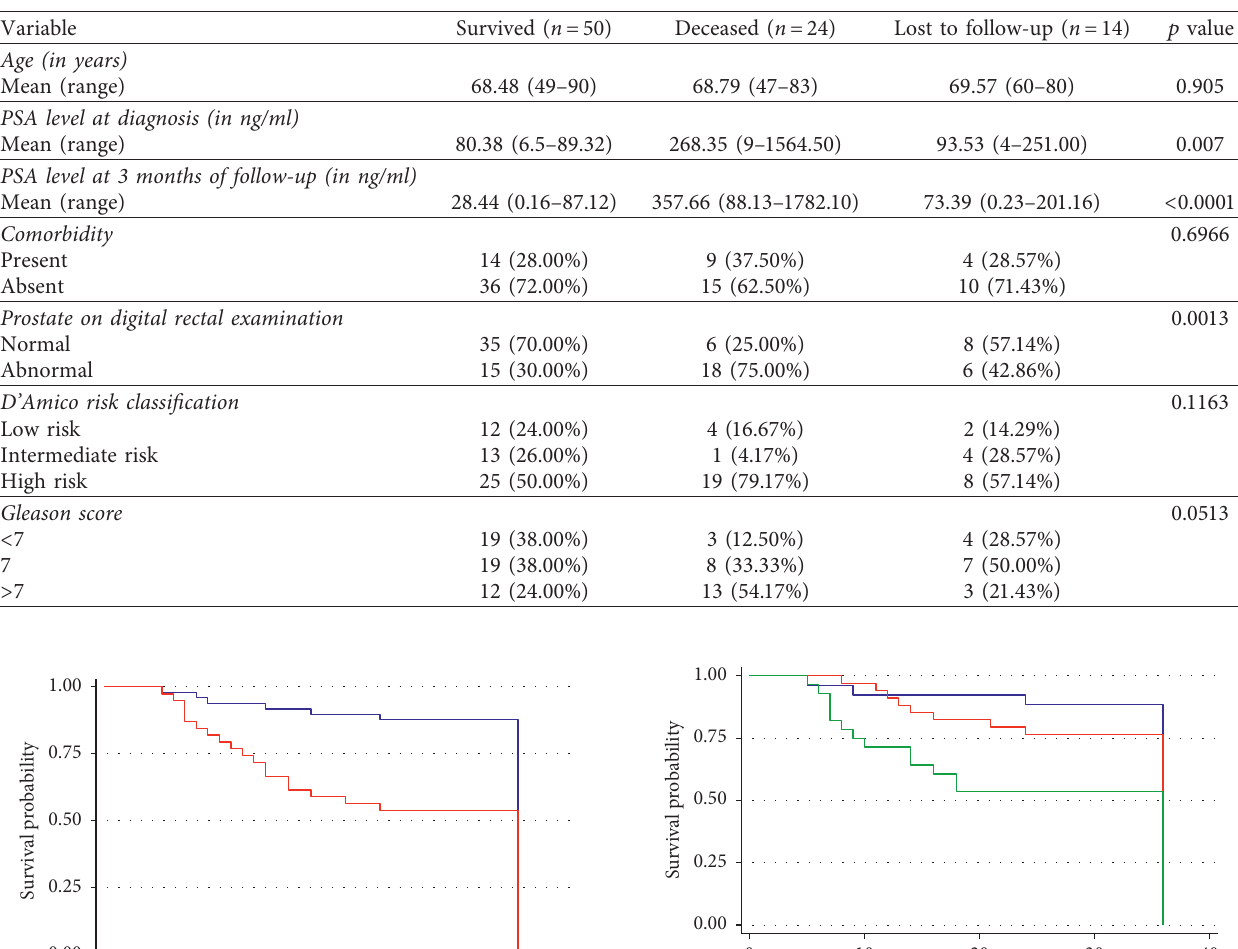
Table 3: Characteristics of the patients according to their outcomes.